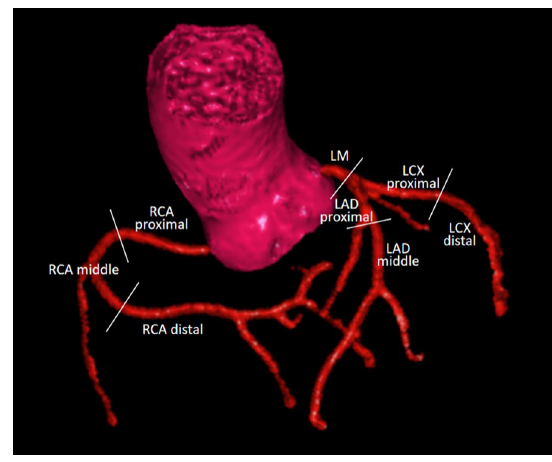
Fig. 3 Eight coronary artery segments evaluated in this study